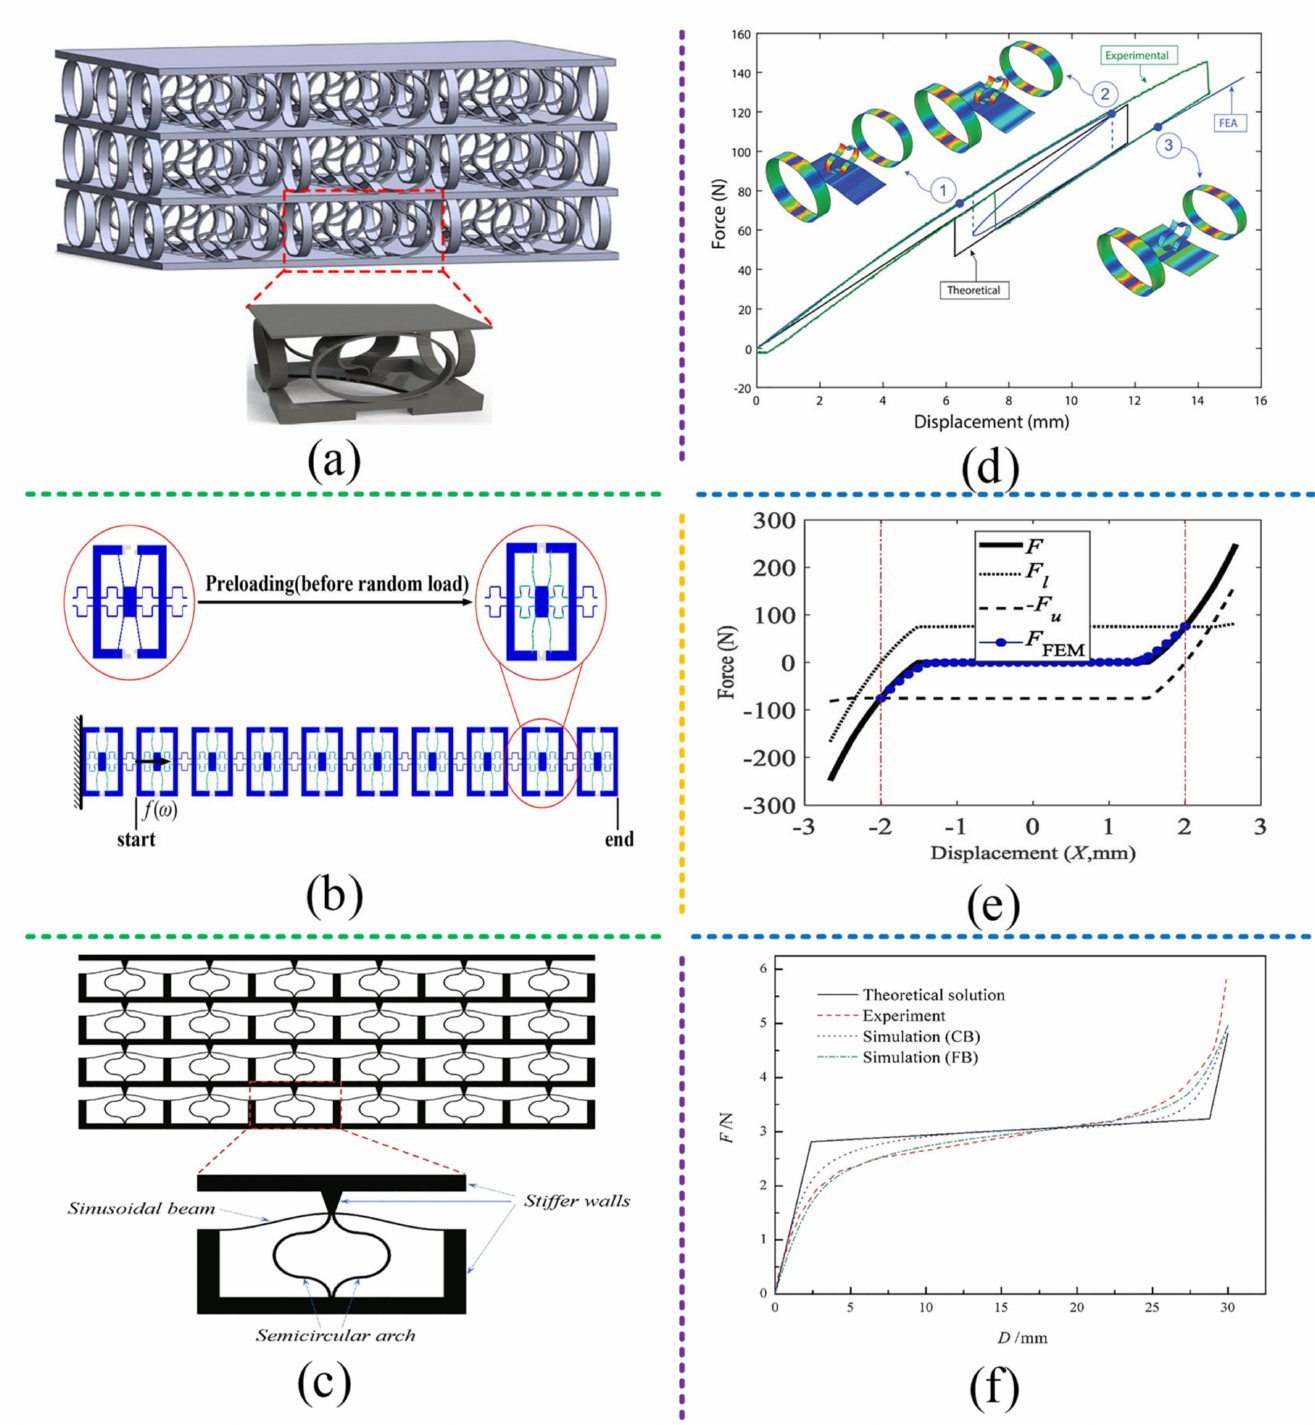
Figure 22. Composite structures: ( a ) the honeycomb-like structure proposed by Izard et al. [113]; figures adapted with permission from Ref. [113]. Copyright 2017, copyright Izard, A.G.; ( b ) The unit cell structure constructed using beams proposed by Zhou et al. [116,117]; figures adapted with permission from Ref. [116]. Copyright 2020, copyright Cai, C.; ( c ) The unit cell structure using a sinusoidal beams, semicircular arches, and stiffer walls designed by Fan et al. [118]; figures adapted from with permission Ref. [118]. Copyright 2020, copyright Fan, H.; ( d – f ) show the corresponding stress-displacement